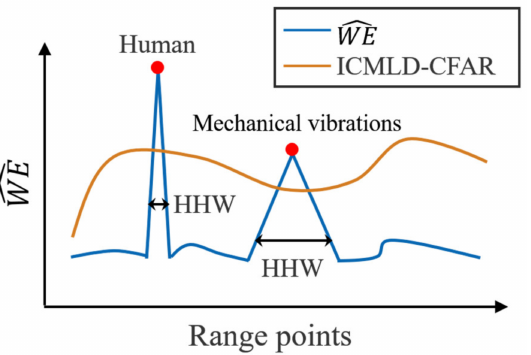
Figure 4. Illustration of the proposed feature of half-height width (HHW) of the target’s wavelet